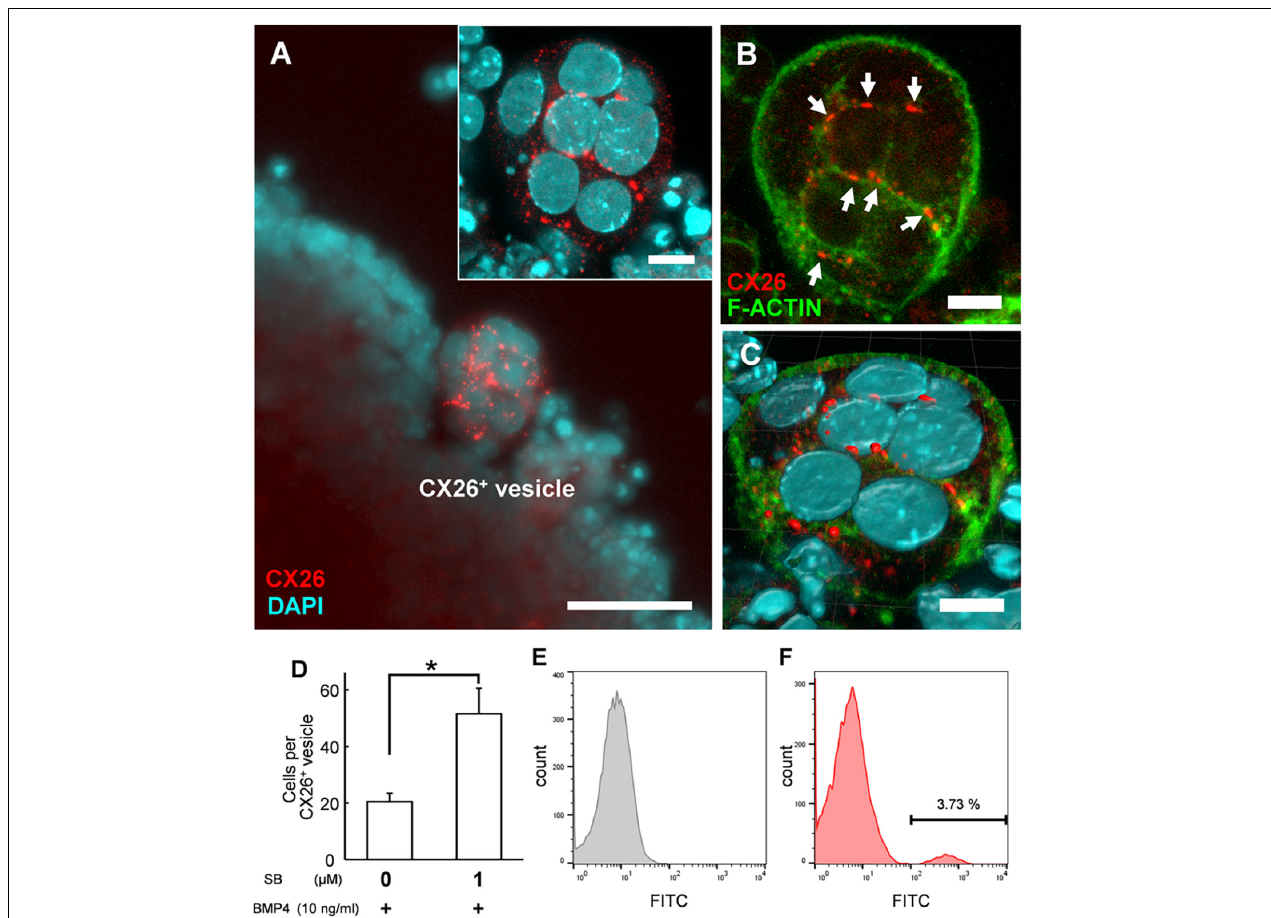
FIGURE 3 | Confocal images of CX26 + vesicles in BMP4/SB-treated ESC aggregates. (A) Merged image of CX26-immunostained (red) and DAPI-stained (blue) cells in CX26 + vesicles. Inset in (A) Higher-magnification image of the CX26 + vesicle from this aggregate. (B) Merged images of CX26-immunostained (red) and F-actin-stained (green) cells in the same vesicle as shown in (A) . Arrows point to GJPs. (C) The three-dimensional image reconstructed from the same CX26 + vesicle. (D) The average number of cells that composed CX26 + vesicle (n = 12–18 CX26 + vesicles from three independent experiments). Statistical differences among treatments were assessed by Student’s t -test; * p < 0.05. (E,F) FACS analysis for CX26 + populations in day 7 aggregate. (E) Gray, control (negative control); (F) Red, Numbers in the histogram indicate the percentage of positive cells. Scale bars: 50 µ m (A) , 10 µ m (inset in A–C ).